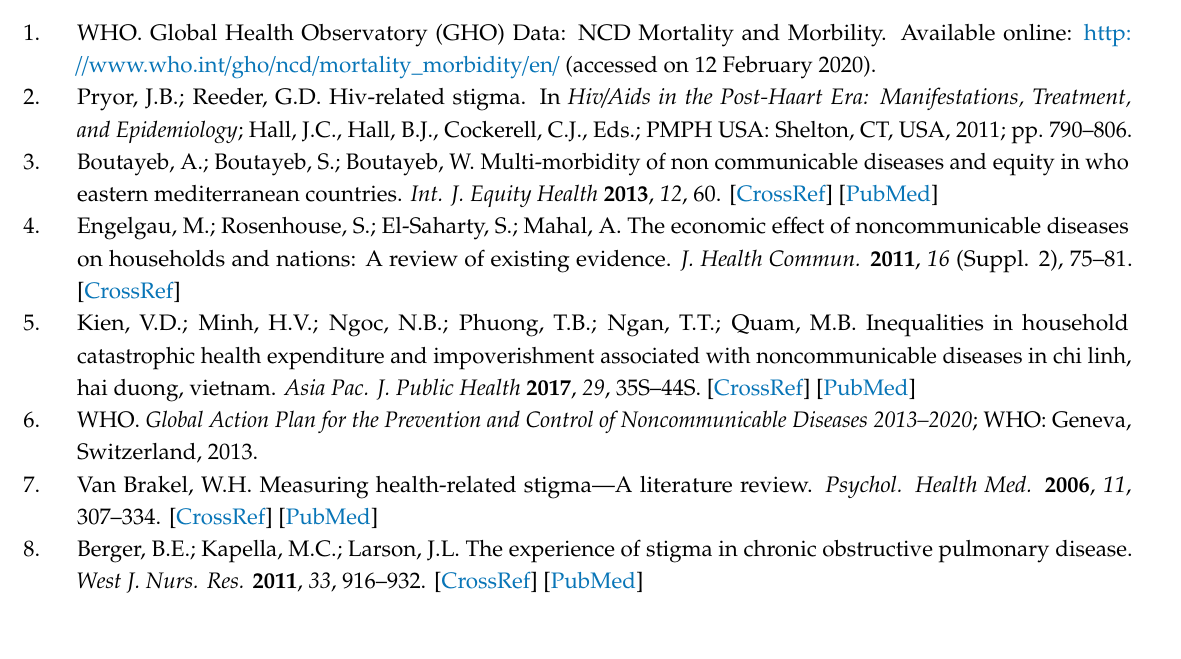
Table S1: PRISMA checklist, Table S2: Search strategy, Table S3: Quality assessment matrix, Table S4: Integrative matrix with summary of qualitative and quantitative